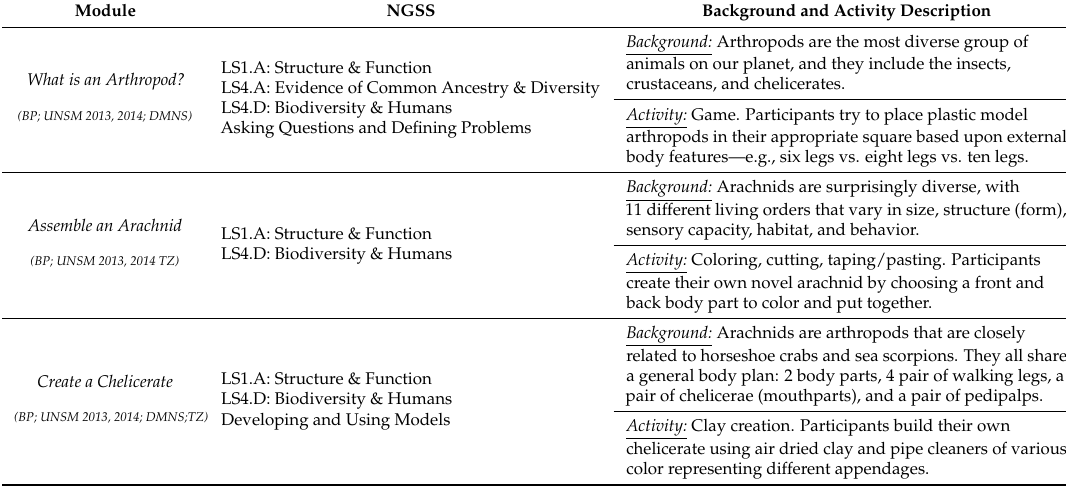
Table 2. Arthropod Classification and Taxonomy Activities, alignment with NGSS (Disciplinary Core Ideas, Science & Engineering Practices) and brief descriptions. Superscript abbreviations represent the venues where activities were incorporated (Butterfly Pavilion, CO 2013 BP ; University of Nebraska State Museum—Morrill Hall, NE UNSM 2013; 2014 ; Denver Museum of Nature and Science, CO 2014 DMNS ; Toledo Zoo 2017 TZ